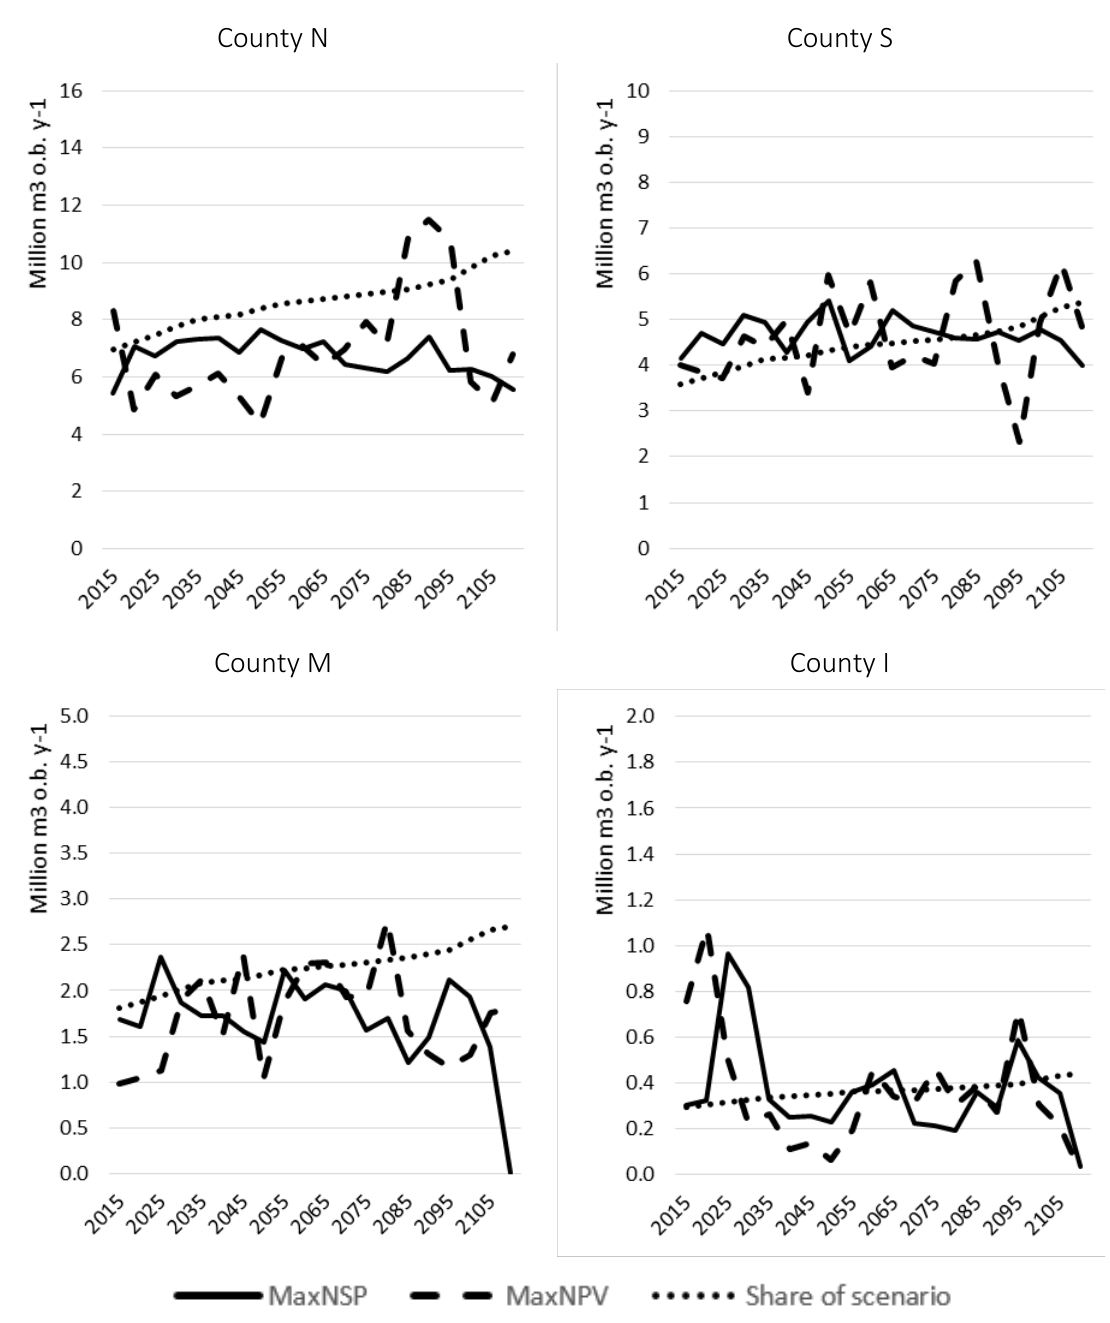
Figure 5. Harvest volumes (m 3 o.b. including treetops) for counties Västerbotten ( N ), Kronoberg ( S ), Västmanland ( M ), and Gotland ( I ) for scenario RCP2p6.SSP4, using NFI plots measured during two years.